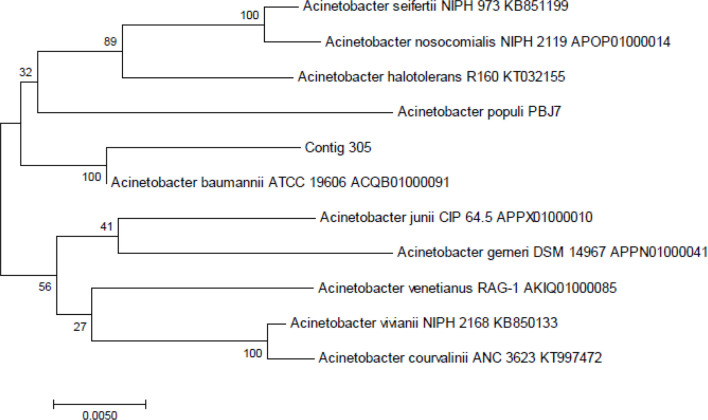
16S rRNA gene sequence-based phylogenetic tree for
A. baumannii
 strain LMEM 305 (contig 305) compared with the sequences of closely related reference bacterial strains retrieved from the NCBI’s GenBank database. Digits shown at the nodes represent the bootstrap values (for a total of 1000 replicates).